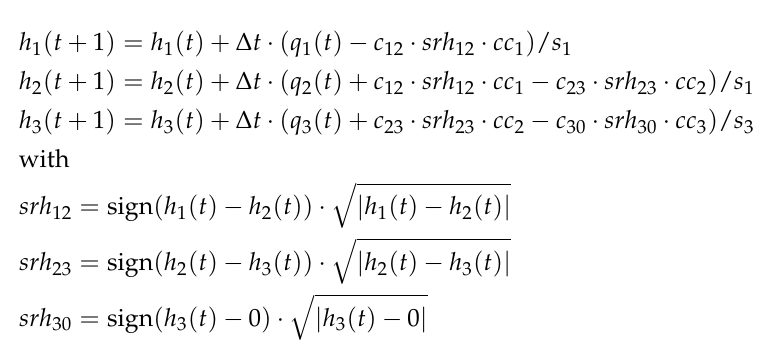
Figure 1. Schematic representation of the three-tank system. 195